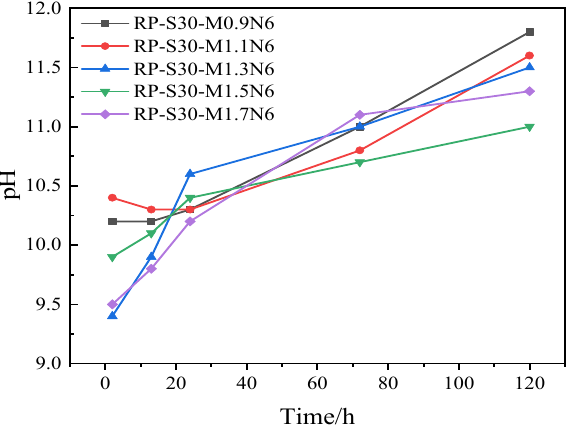
Figure 16. PH values of RPSG with different moduli.